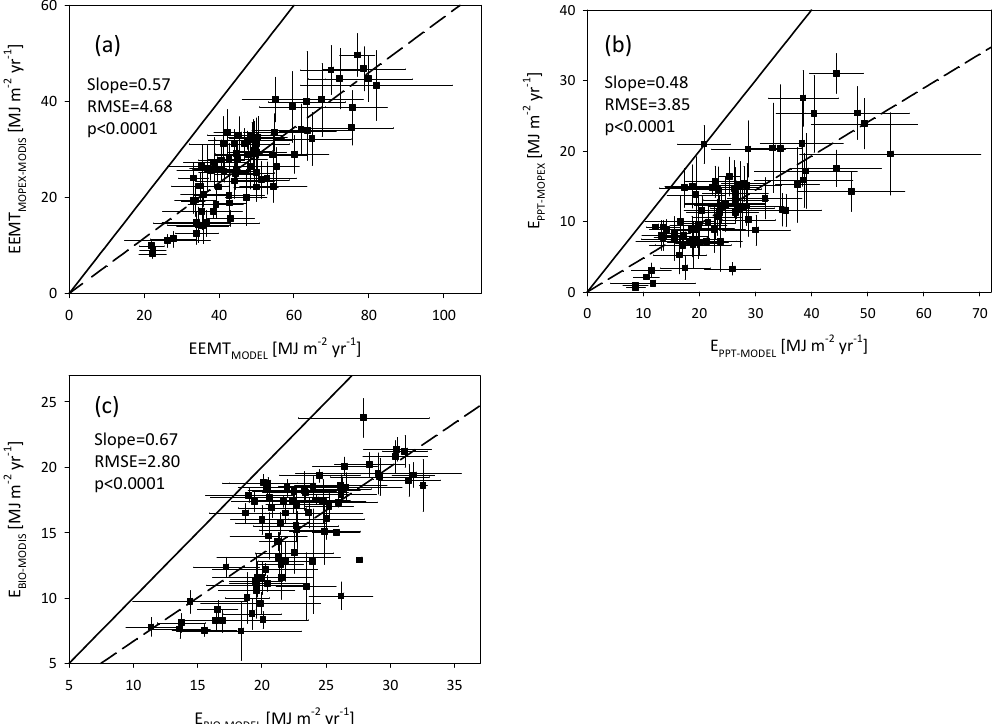
Fig. 1. The relationship between (a) effective energy and mass transfer (EEMT) quantified using MOPEX baseflow and MODIS net primary production data (EEMT MOPEX-MODIS ) relative to modeled EEMT (EEMT MODEL ), (b) water transferred heat energy input derived from MOPEX baseflow data ( E PPT-MOPEX ) and modeled heat transfer ( E PPT-MODEL ), and (c) biological chemical energy input derived from MODIS net primary production ( E BIO-MODIS ) and modeled primary production ( E BIO-MODEL ). The 1:1 relationship is noted as solid lines, and the dashed lines represent best fit linear functions fit with an intercept of zero. Error bars are standard errors of the annual means over the period of record.